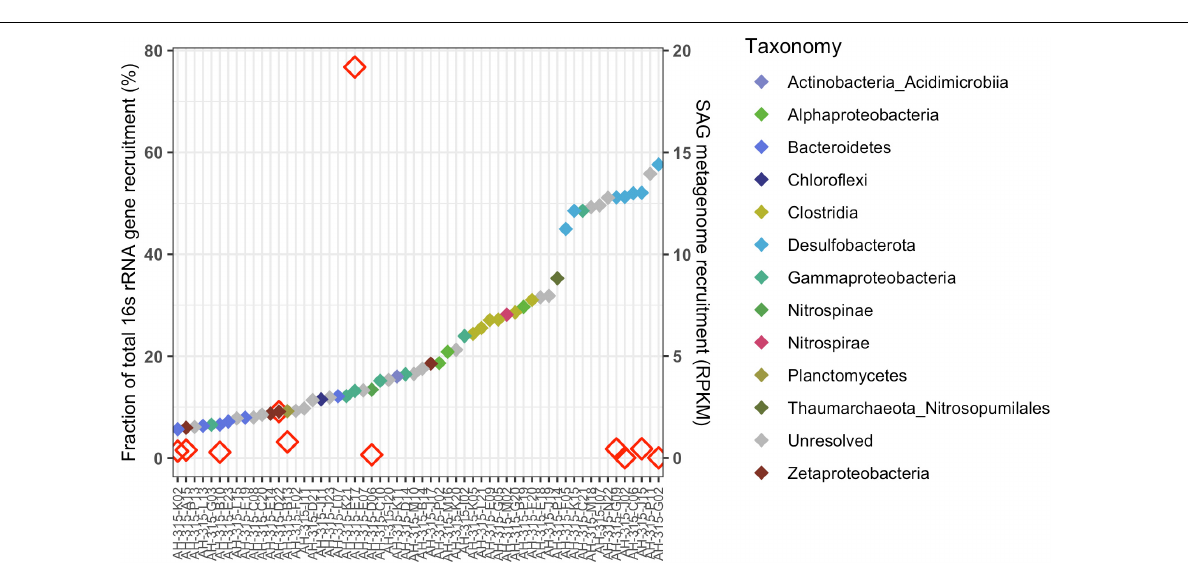
FIGURE 3 | Recruitment of metagenomic (DNA) reads from the 2017 Hole U1383C Deep sample to the activity-based low-coverage SAGs from this same sample (displaying the SAGs having above-mean RPKM values, n = 58), sorted by SAG name (x-axis) from left to right in order of increasing recruitment value in reads per thousand million (RPKM) shown with colored filled diamonds according to the right y-axis. Symbol color indicates the taxonomy of the SAG at Class level per the legend. Fifteen of these low-coverage SAGs contained ribosomal genes, indicated by the open red diamonds. The fraction of total metatranscriptomic reads that mapped to 16S rRNA genes in these 15 SAGs is indicated on the left y-axis. Of note, all of the seven Desulfobacterota SAGs had the highest recruitment coverage, followed by SAGs from Gammaproteobacteria, Thaumarchaeota, Clostridia , Alphaproteobacteria , Nitrospira, and some